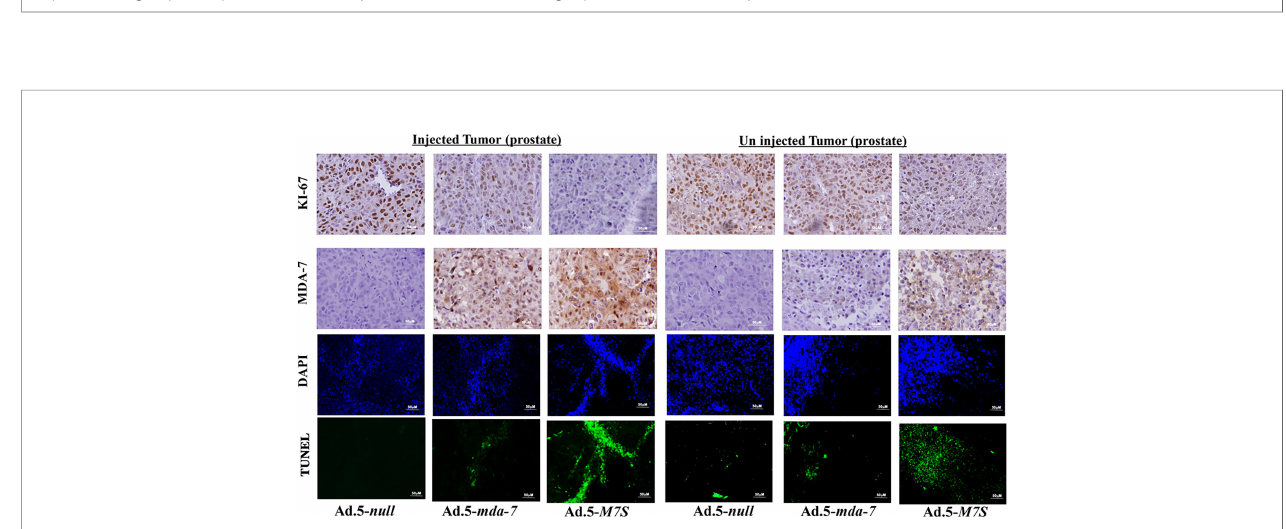
FIGURE 7 | Immunohistochemical analysis of prostate cancer xenograft tumors injected with Ad.5- mda- 7 or Ad.5- M7S . IHC analysis of MDA-7/IL-24 and Ki-67 in the different tumor sections from melanoma xenograft tumors (from Figure 5B ) are as shown. Sections were also immunostained with by TUNEL to determine apoptosis and DAPI for nuclear staining. Representative photographs are presented from each experimental group. Left panels show the injected tumors while the right panels show the un-injected